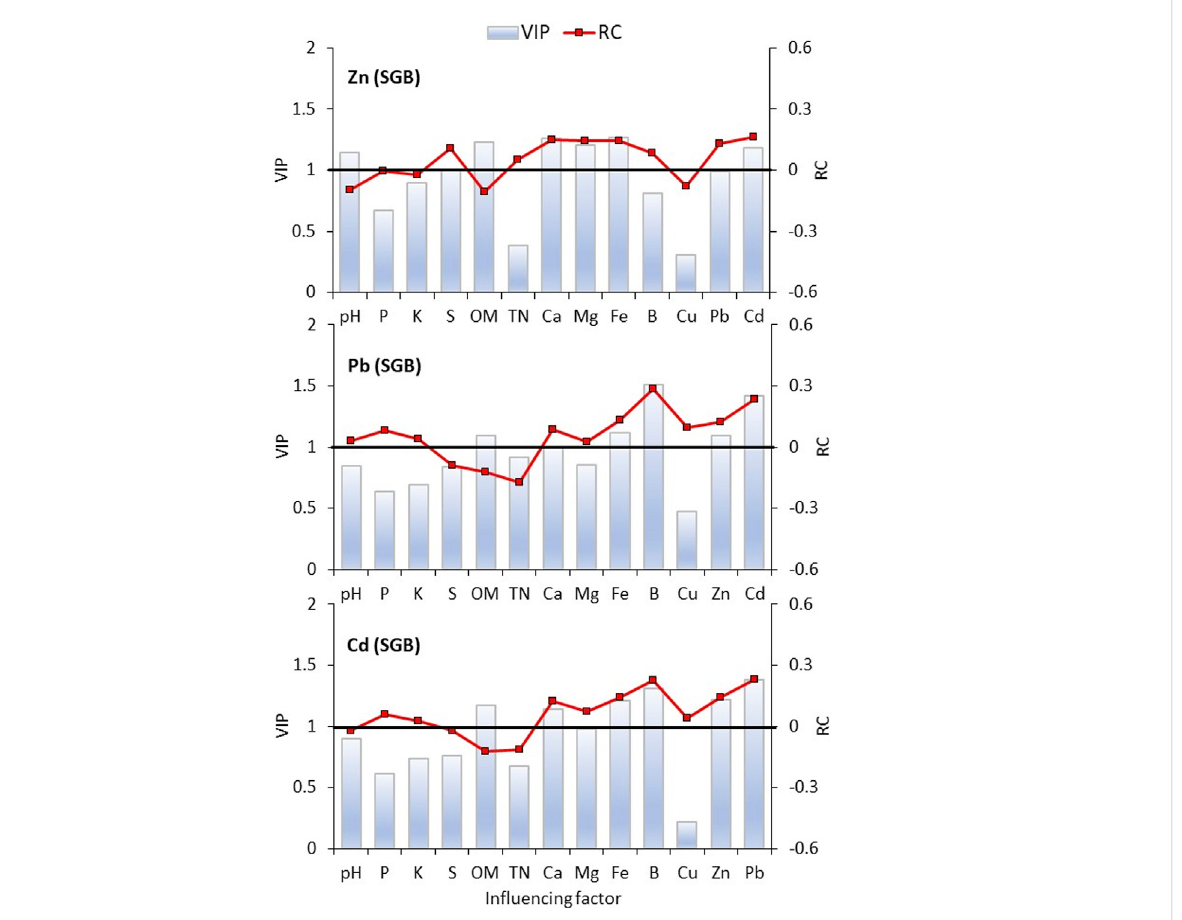
FIGURE 5 Partial Least Square Regression model (PLSR) of factors in fl uencing the content of heavy metals in a soilamended with switchgrass-derivedbiochar (SGB). VIP is Variable Importance in Projection. When VIP > 1, it means that the independent variable is important for predicting the dependent variable; whereas it is less important at VIP < 0.5. The regression coef fi cients (RC) indicate the action direction of each independent variable. Results comprise the whole dataset of